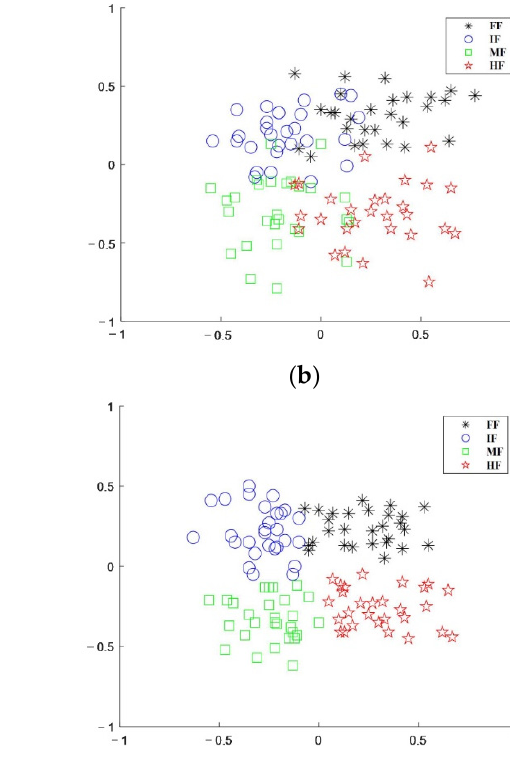
Figure 7. The ROC curve of four kinds of SVM classifiers.